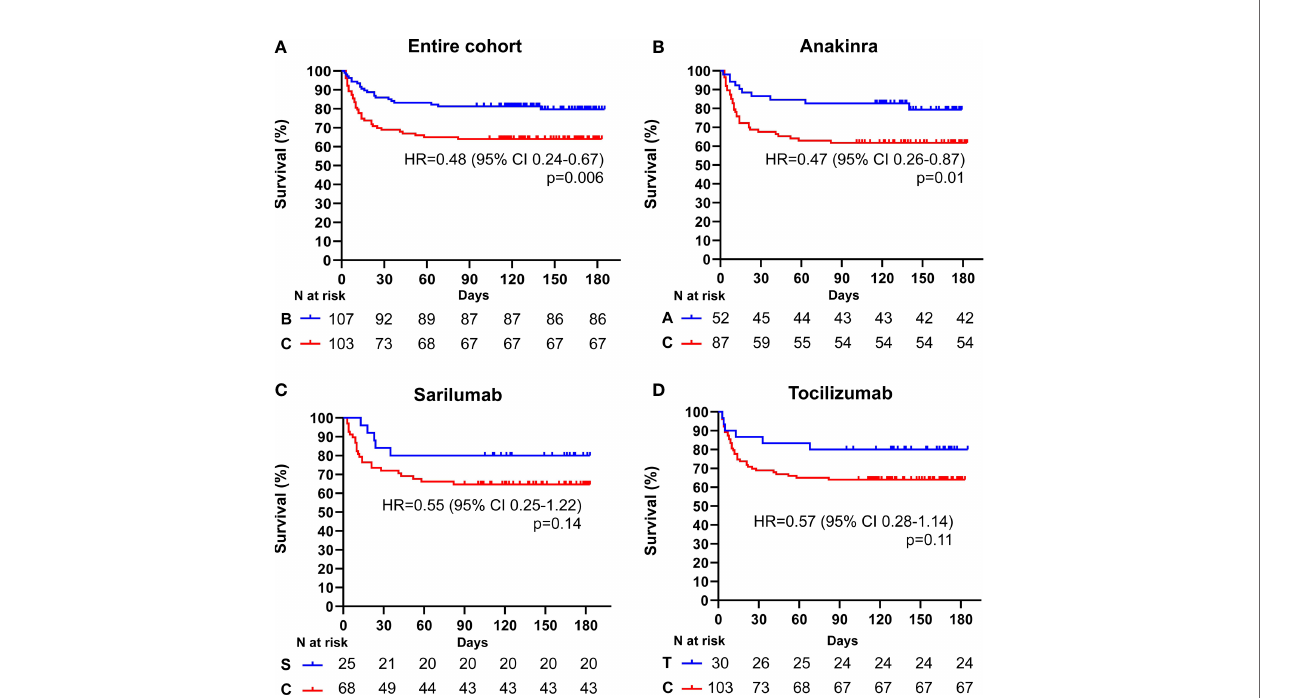
FIGURE 1 | Cumulative incidence of long-term survival of patients treated with biologic drugs compared to patients treated with standard of care: entire patient cohort. Kaplan-Meier curves showing the cumulative incidence of overall survival up to 186 days of the entire cohort of patients treated with biologic drugs (A) , anakinra (B) , sarilumab (C) , and tocilizumab (D) compared to patients treated with standard of care. Time to death is expressed in days from the day of enrolment. A, anakinra; B, biologic drugs; C, comparators treated with standard of care; S, sarilumab; T, tocilizumab; HR, hazard ratio; CI, con fi dence interval. Statistically signi fi cant p value < 0.05.